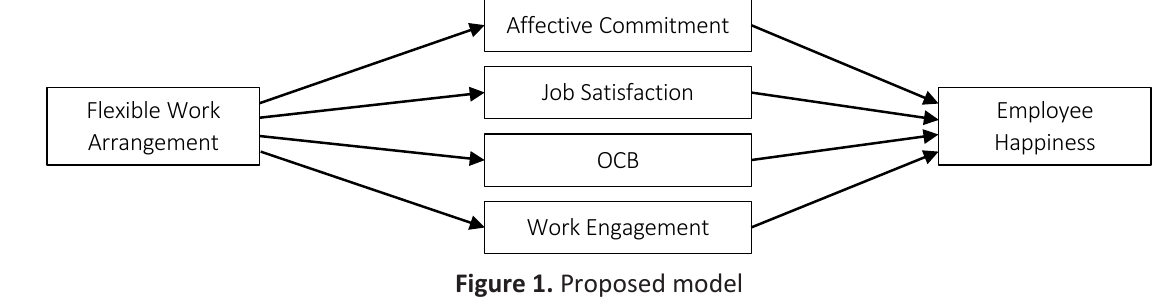
Figure 1. Proposed model